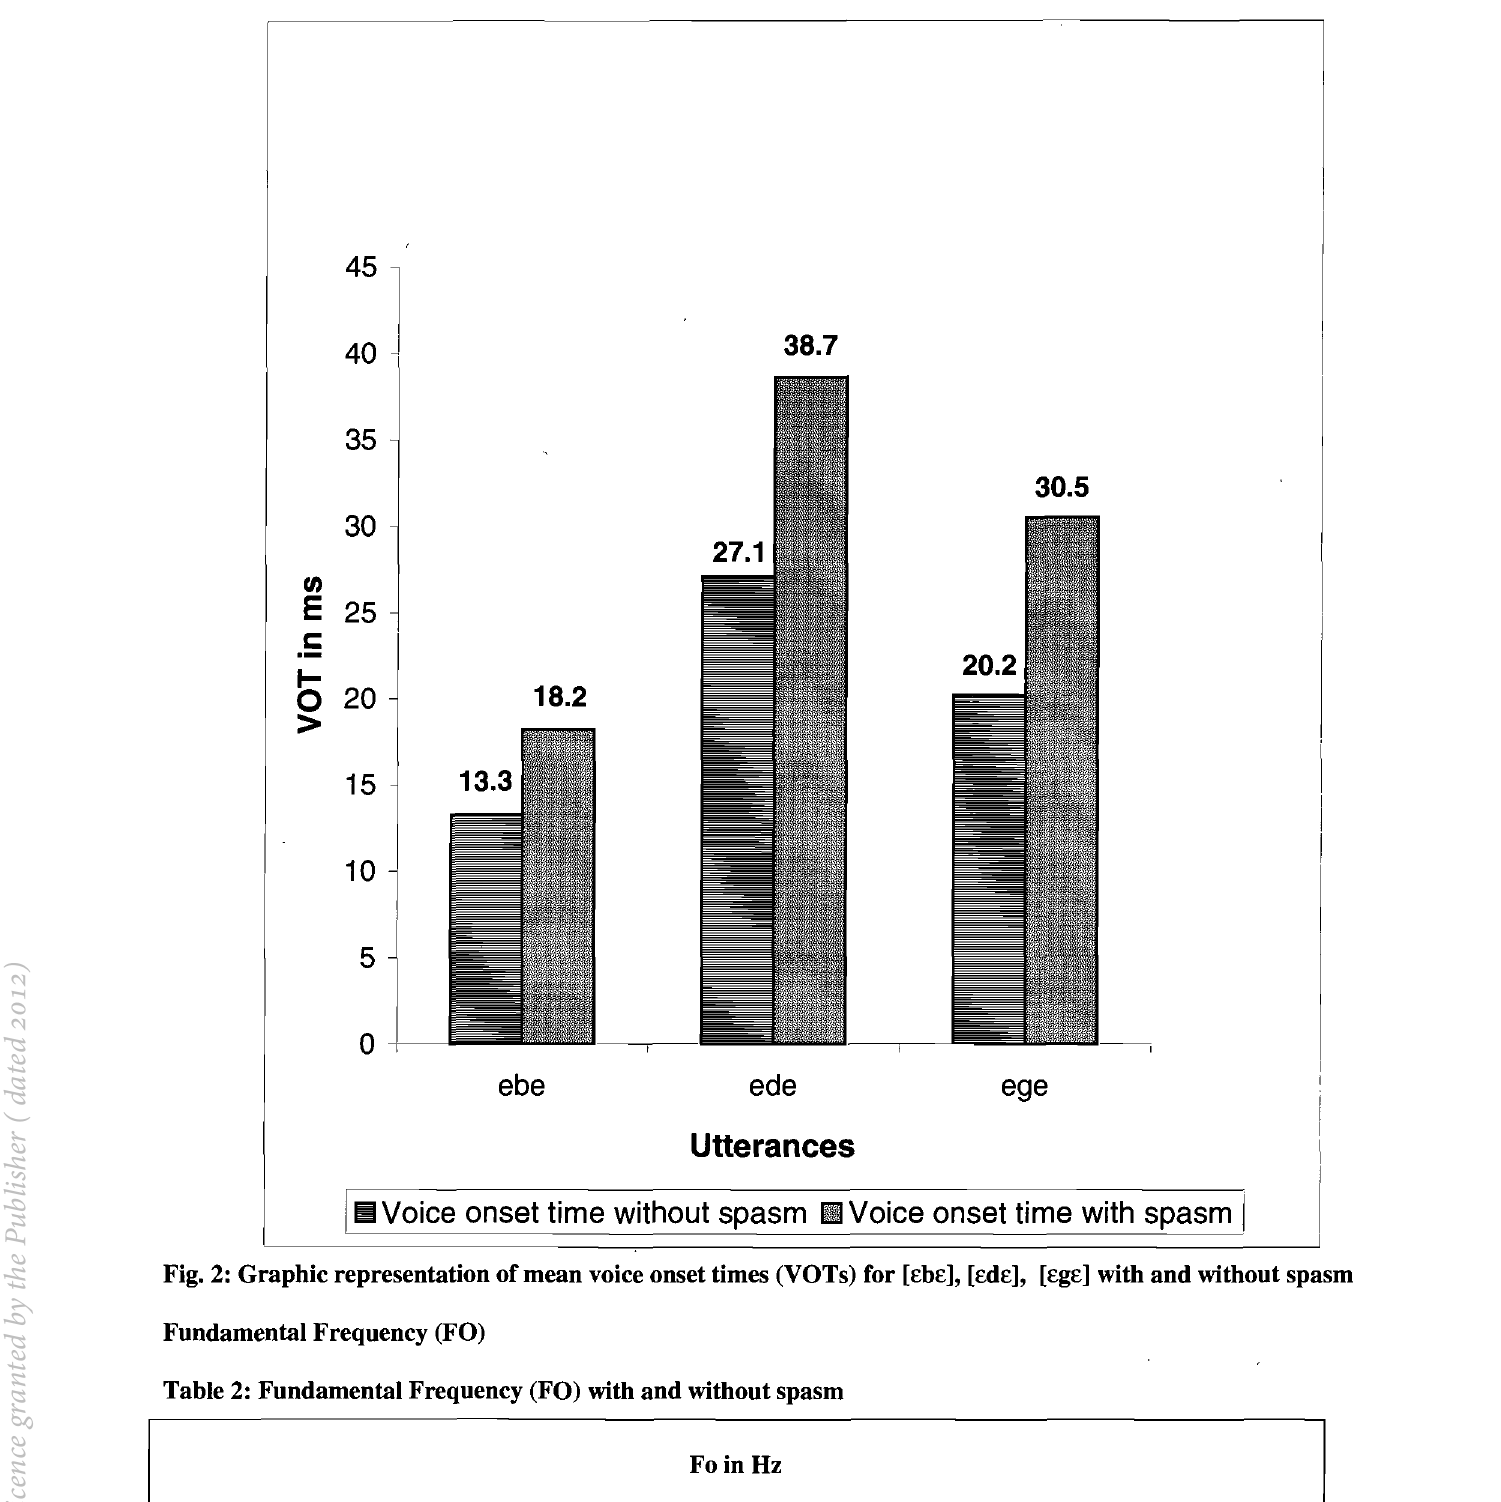
Fig. 2: Graphic representation of mean voice onset times (VOTs) for [ebe], [ede], [ege] with and without spasm Fundamental Frequency (FO) Table 2: Fundamental Frequency (FO) with and without spasm Fo in